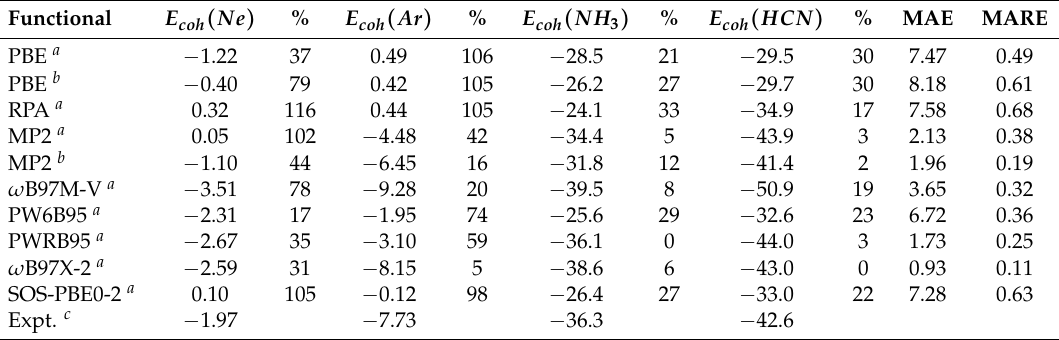
Table 3. Same as Table 2, but with basis sets of TZ quality. b exploits basis sets of augmented DZ quality.